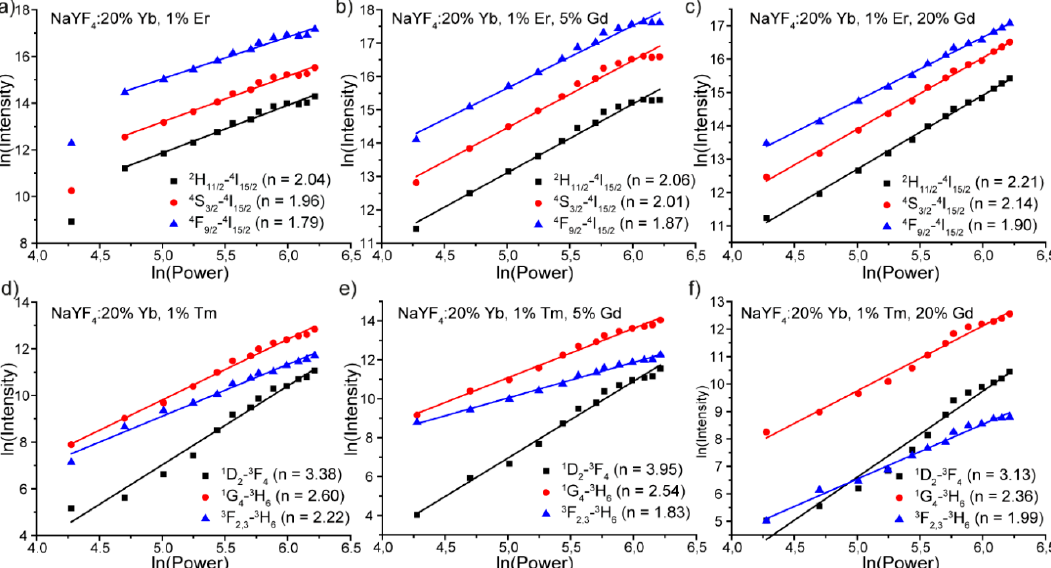
Figure 6. Dependence of integral upconversion luminescence on laser power of ( a ) NaYF 4 : 20% Yb, 1%